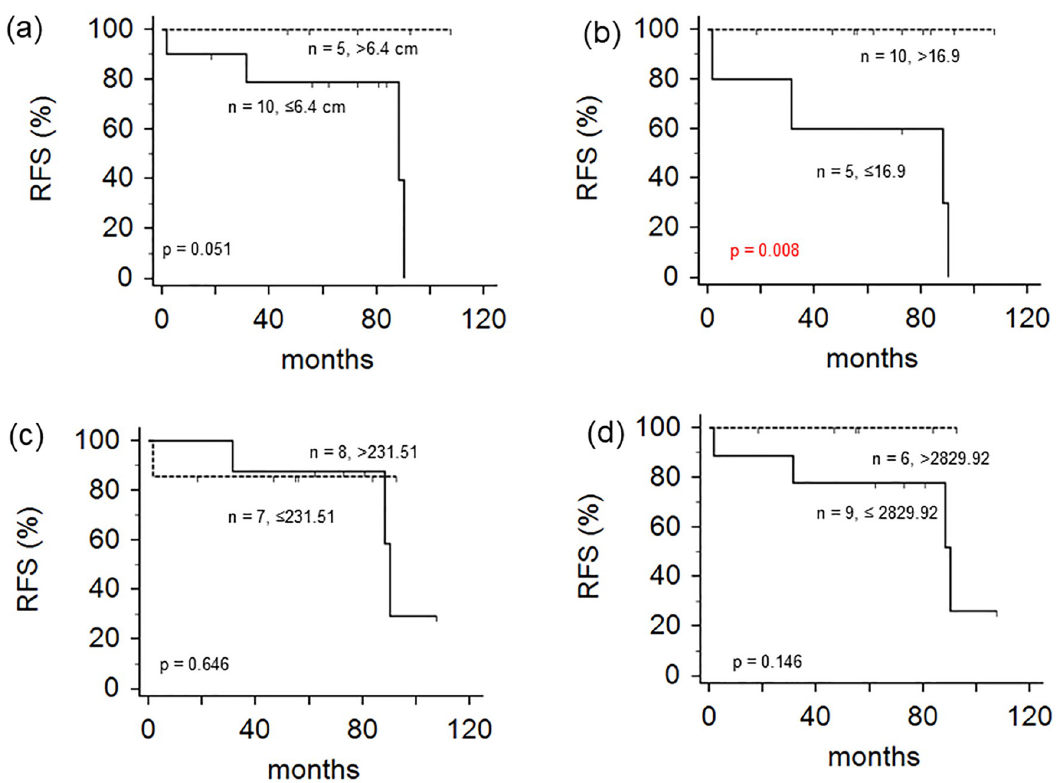
Fig 2. Kaplan-Meier survival curves depicting relapse-free survival (RFS) according to tumor size (a), the maximum standardized uptake value (SUVmax) (b), metabolic tumor volume (MTV) (c), and total lesion glycolysis (TLG) (d).